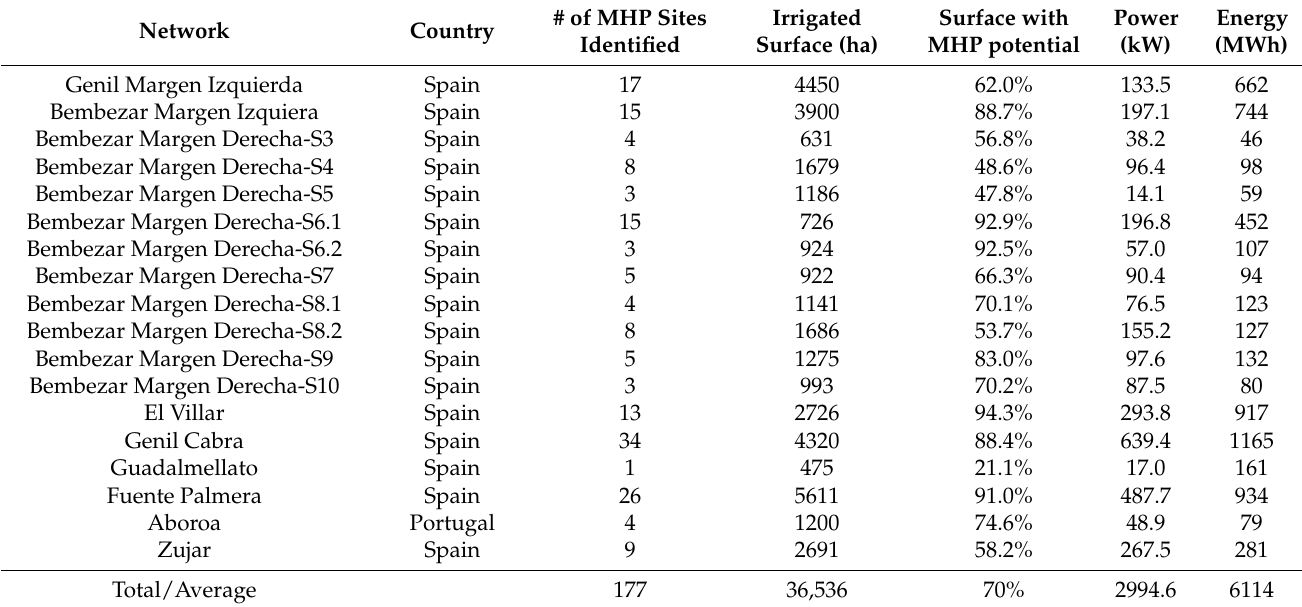
Table 5. MHP energy potential estimates from the analysis of 18 irrigation network models in Spain and Portugal [30]. Network Country